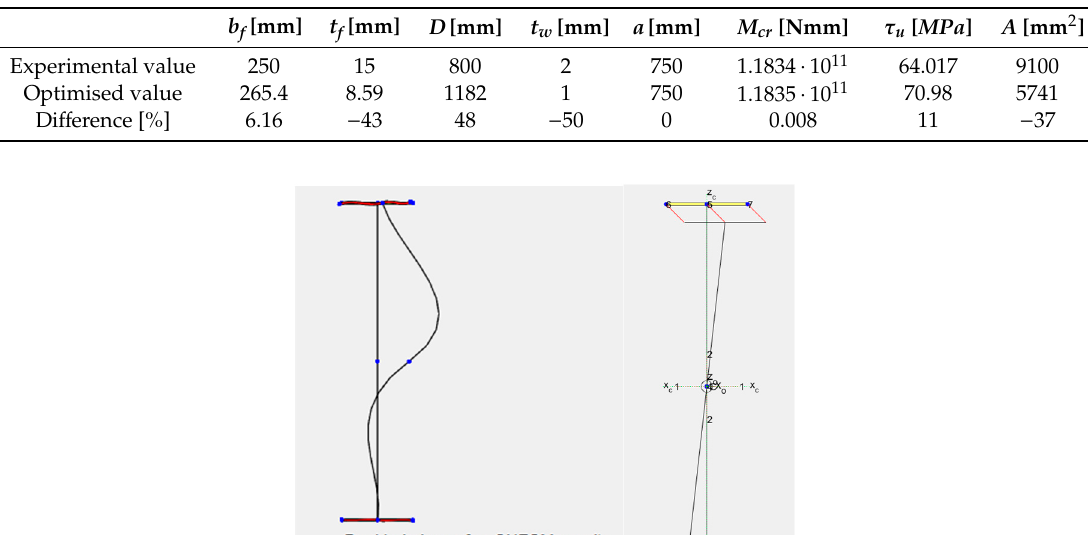
Figure 6. Results of the analysis with finite strip method using the software package CUFSM for the slender web .